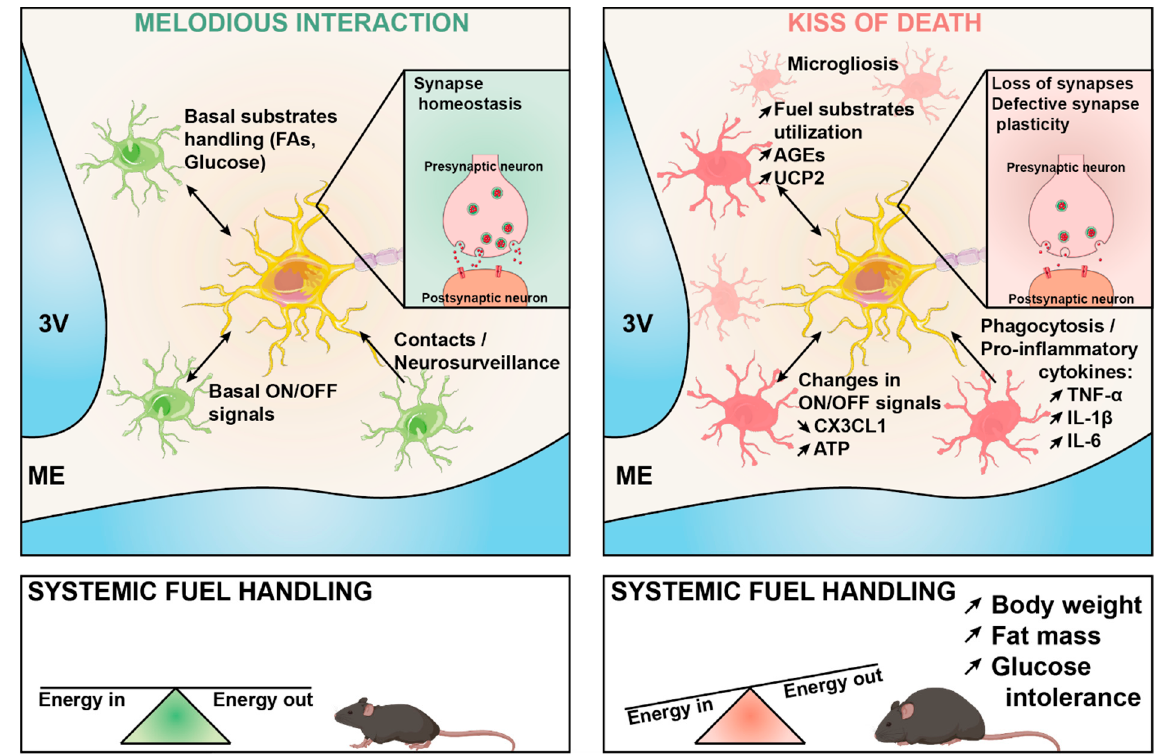
Figure 1. Under physiological conditions ( left ) microglia play a key role in fine-tuning neuronal synaptic function in response to changes in the energy status of the body. This involves different mechanisms including the release of ON-OFF signals, the intercellular production of metabolic messengers in response to the cellular metabolism of fuel substrates, and physical intercellular contacts that are necessary for neurosurveillance. This melodious interaction may become maladaptive during diet-induced obesity ( right ), thereby leading to impaired synaptic plasticity through multiple possible mechanisms, which are highlighted in the figure. The maladaptive cross-talk ultimately results in energy balance dysregulation, obesity, and systemic glucose intolerance. FA: fatty acids; AGEs: advanced glycation end-products; UCP2: uncoupling protein 2; CX3CL1: C-X3-C motif chemokine ligand 1; ATP: adenosine 5 ′ - triphosphate; TNF α : tumor necrosis factor-alpha; IL-1 β : interleukin 1 beta, IL6: interleukin 6.